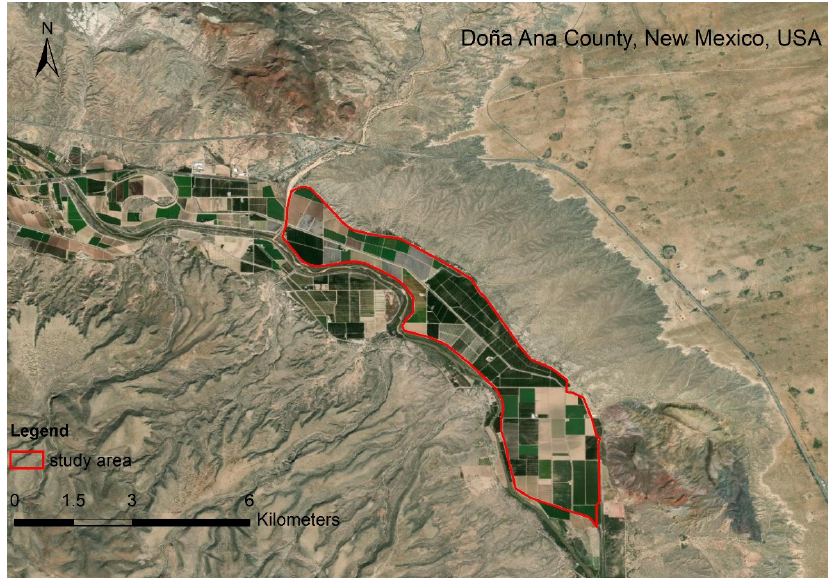
Figure 2. The study area at Doña Ana County, NM,